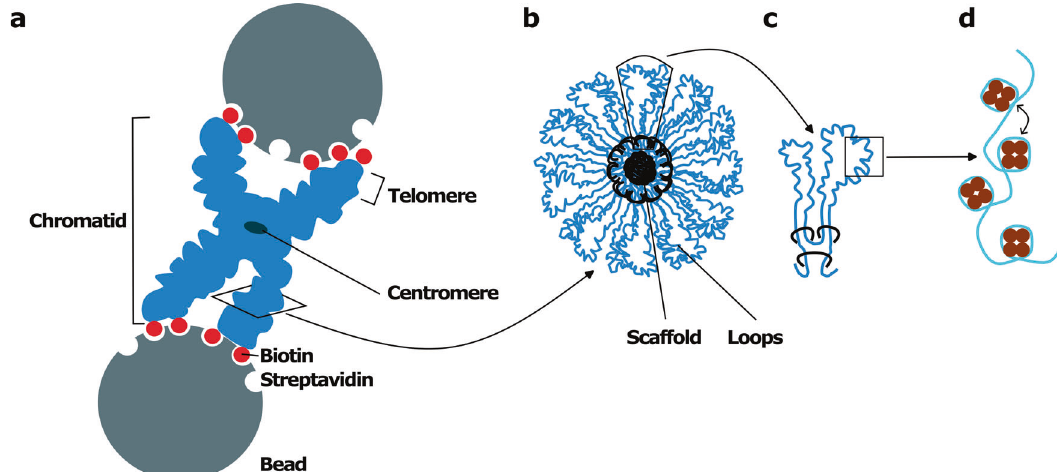
Fig. 1 Scheme of force measurements on a mitotic chromosome using optical tweezers manipulation and model of chromosome organization. a In the optical tweezer setup a single chromosome, consisting of two chromatids, is trapped between two streptavidin-coated beads by interaction with their biotinylated telomeres, the end points of each chromosome arm. Pulling the two beads apart reveals mechanical properties of the chromosome. b Scheme of a cross section through a chromosome arm with the central scaffold indicated in black and looped-arranged chromatin in blue. c Chromatin loops (blue) with condensin I and II complexes (black). d Magni fi ed chromatin region indicating the nucleosome arrangement with histone octamers (brown) around which the DNA-stand (light blue) wraps. Further compaction possibly arises due to histone modi fi cations favoring inter-nucleosome interaction indicated by the two-headed